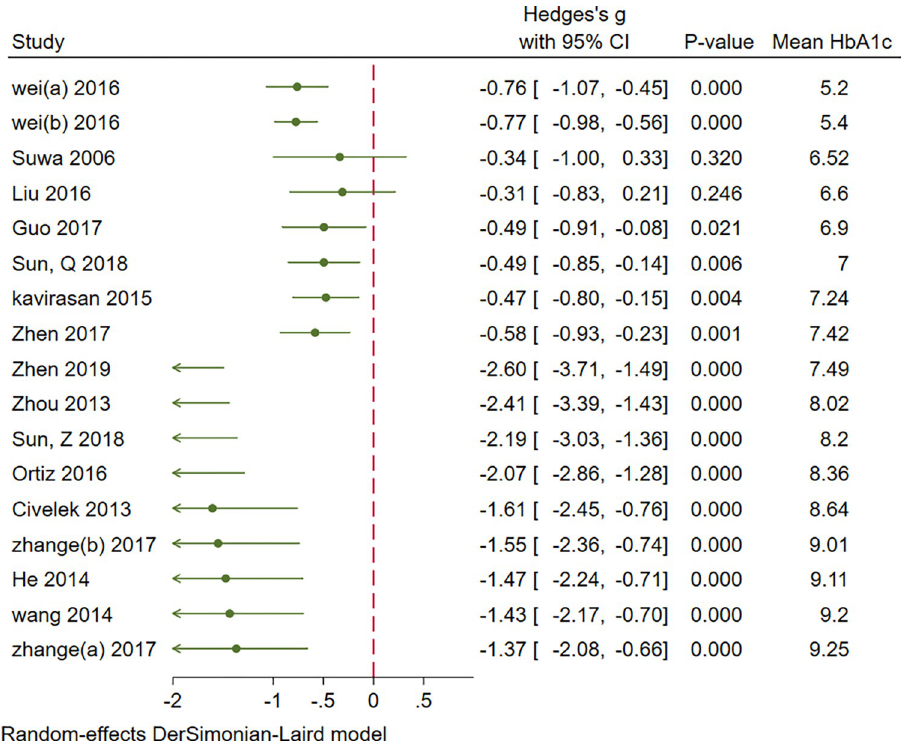
Fig 11. Cumulative meta-analysis of BDNF levels in patients with DM by mean HbA1c of cases.